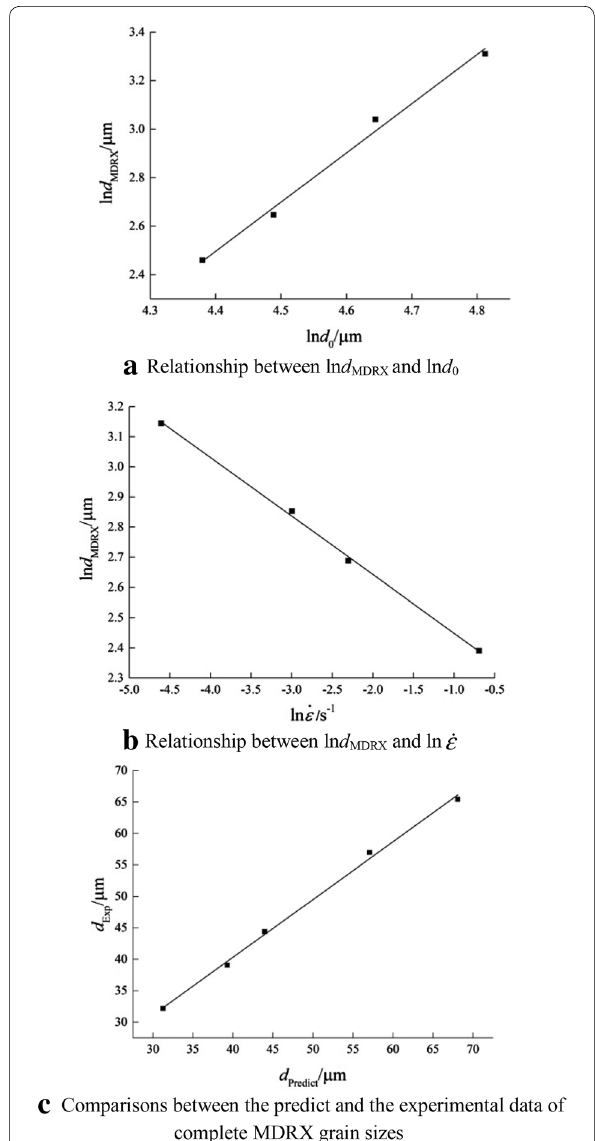
Figure 8 Calculation on the different constants of MDRX grain size model and comparisons between the predict and the experimental data of complete MDRX grain